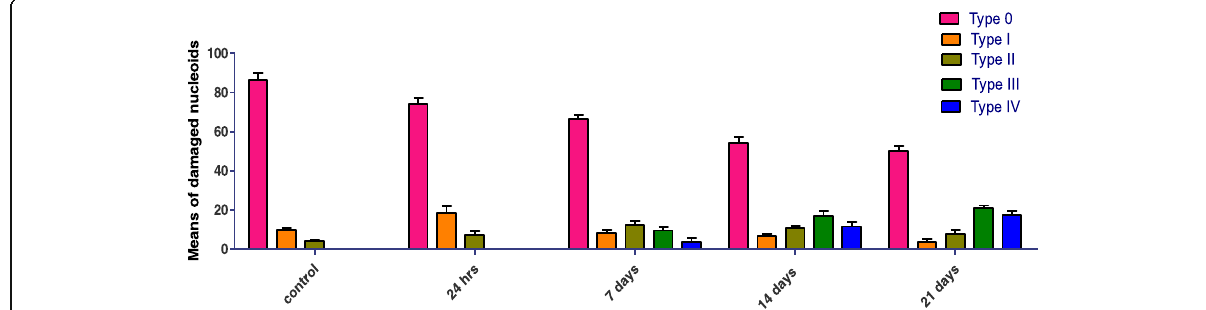
Fig. 6 Graph representing nucleoids in various degrees of damage (mean ± S.D.) in the gill of C. carpio during sub-lethal exposure to